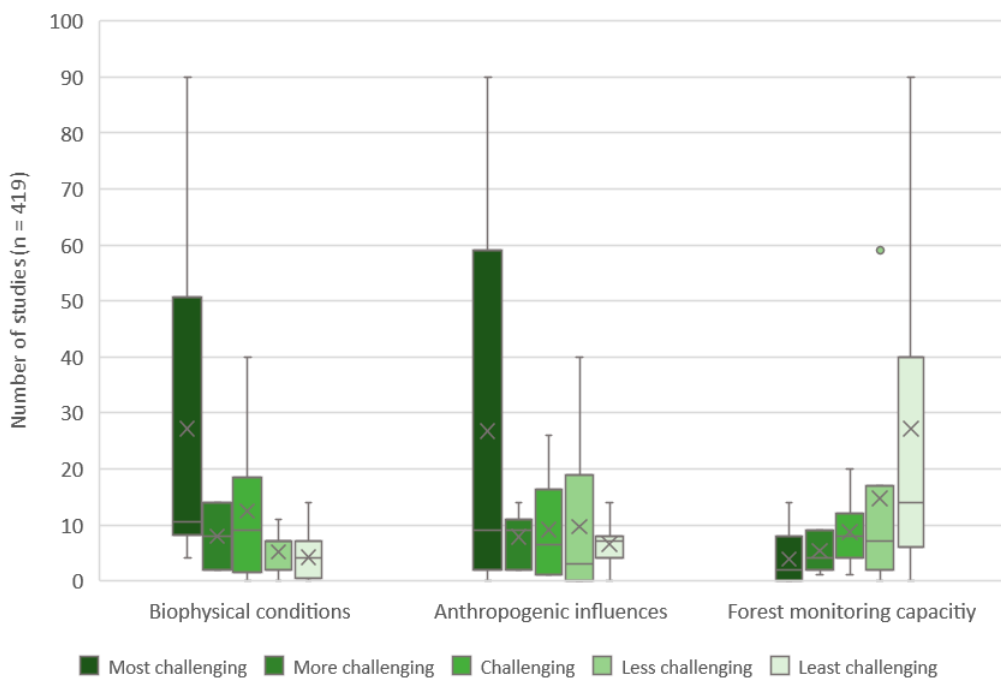
Figure 7. Box and whiskers plot representing the proportion of studies per country in relation to their level of challenge for forest monitoring research. The “X” in each box represents the mean number of studies per countries classified in the categories of challenge.